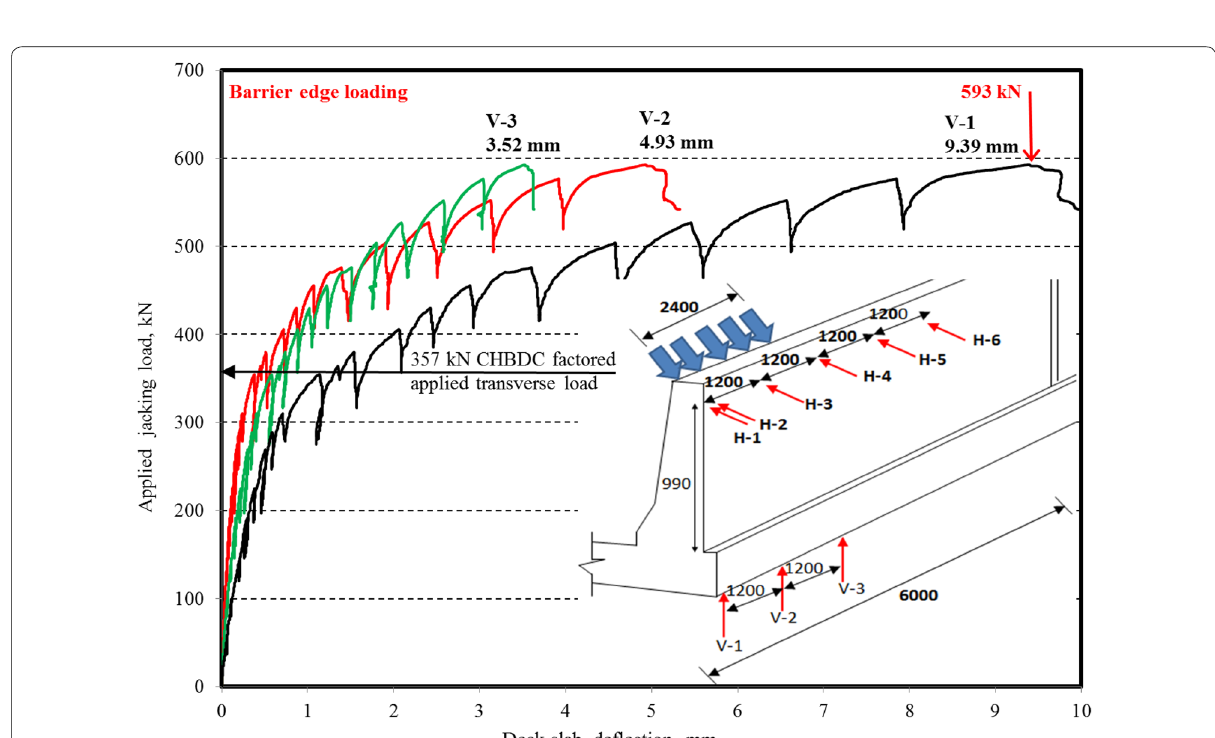
Fig. 8 Load-deflection relationship of the deck cantilever of the barrier wall loaded at end